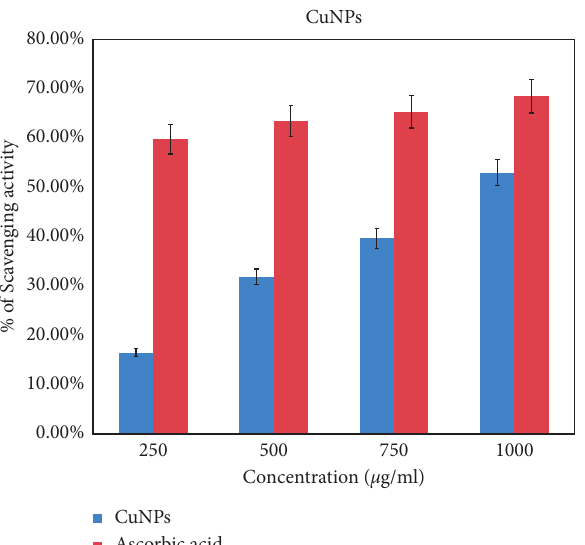
Figure 9: Antioxidant activity of copper nanoparticles against DPPH free radical. Y -axis: percentage of inhibition in mm, and X -axis: concentration of